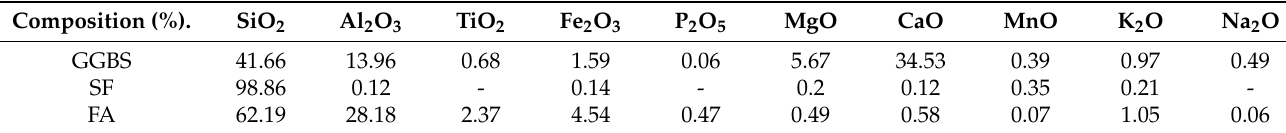
Figure 2. TEM of ASM, ( a )GGBS; ( b ) SF; ( c ) FA. Table 1. Chemical composition of the ASM.